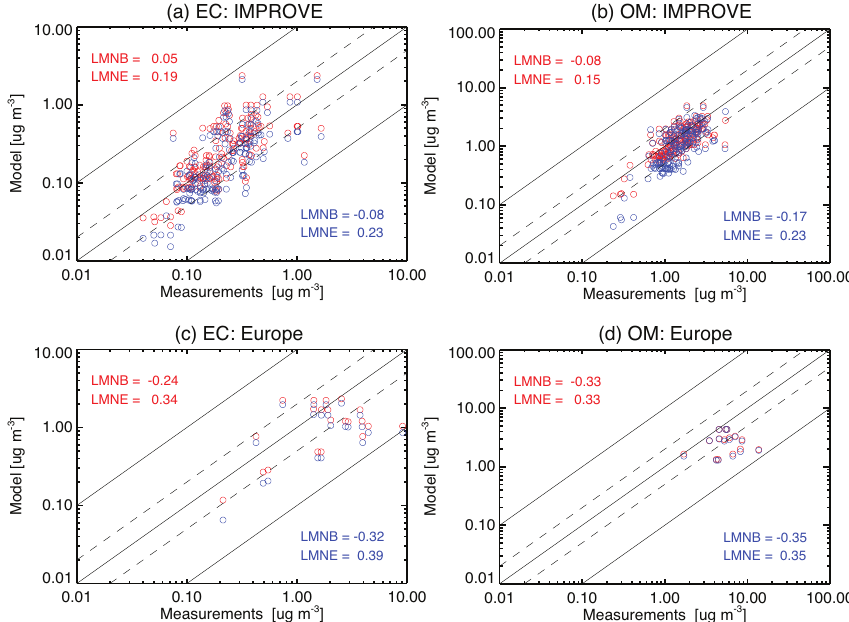
Figure 15. Scatter plots of annually averaged surface EC and OM mass concentrations (µgm − 3 ) simulated (red for ModelE2-TOMAS and blue for ModelE2-OMA) and observations from the IMPROVE network ( a and b ) and the European sites from Putaud et al. (2010) ( c and d ). (b) PM2.5 - ModelE2-OMA